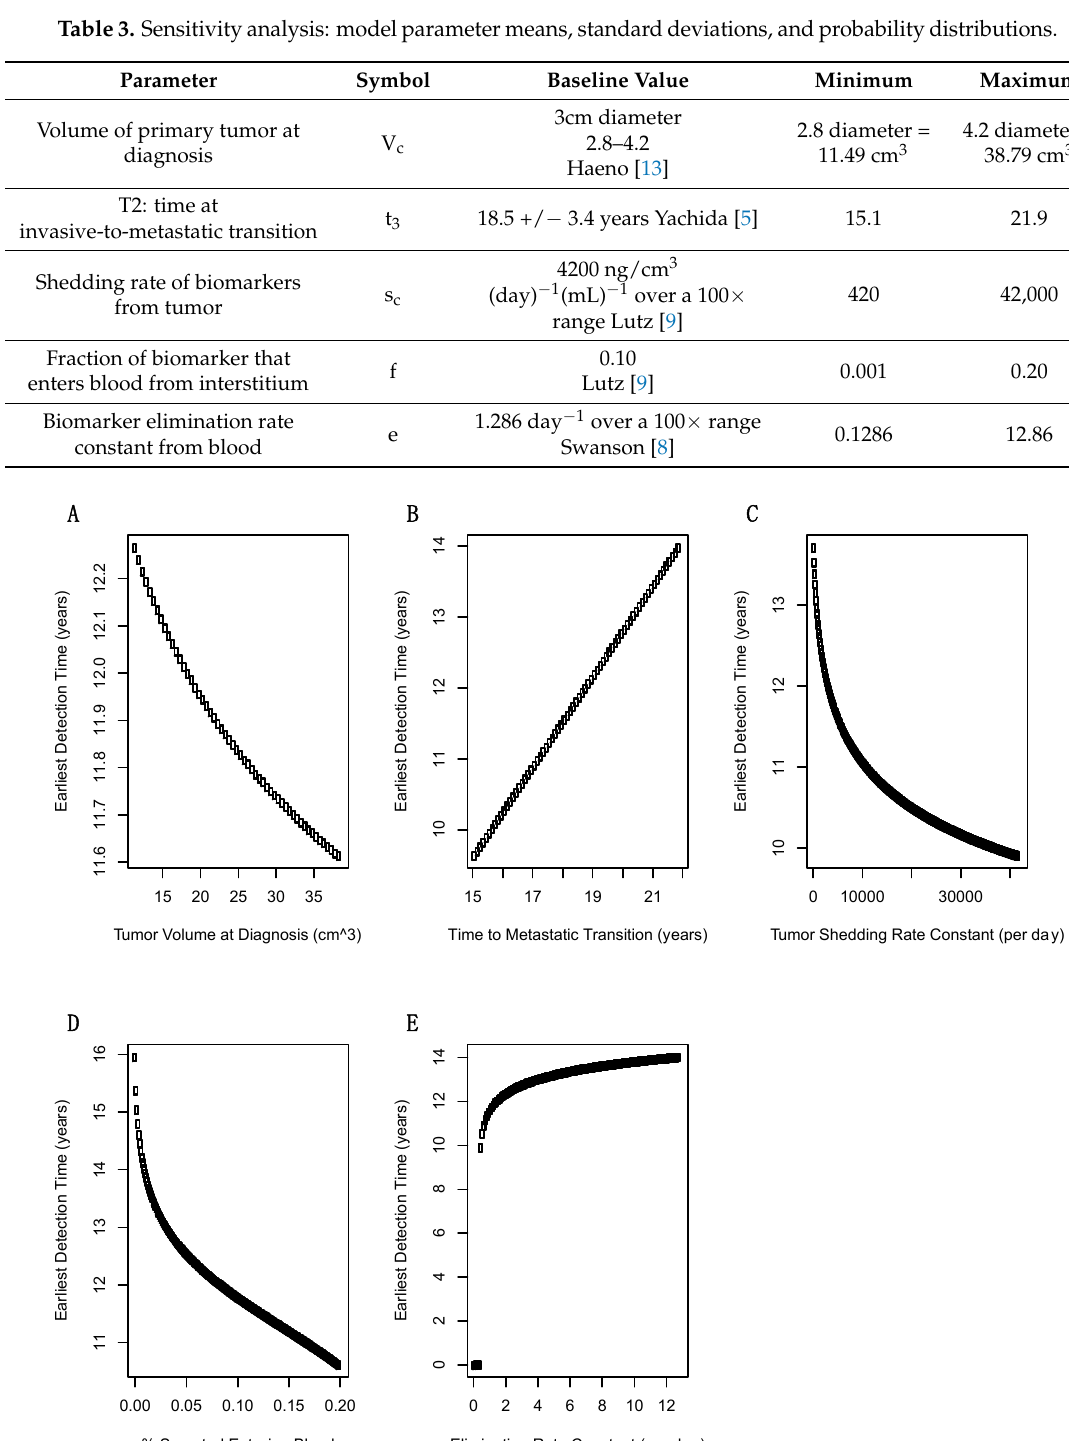
Figure 4. Sensitivity of minimum detection times over one-dimensional scans of model parameters. ( A ) For the range of tumor volumes at diagnosis there is minimal effect on earliest detection time. ( B ) There is a linear dependence between time to metastatic transition (T2) and earliest detection time that has an important effect on when biomarker screening should begin. ( C ) Tumor biomarker shedding rate constant has a exponential effect on earliest detection time and is therefore, a critical parameter. ( D ) The fraction of secreted biomarker entering blood also has an exponential effect on earliest detection times. ( E ) The blood elimination rate constant has important effects that are generally mild at the most likely values of >2 day − 1